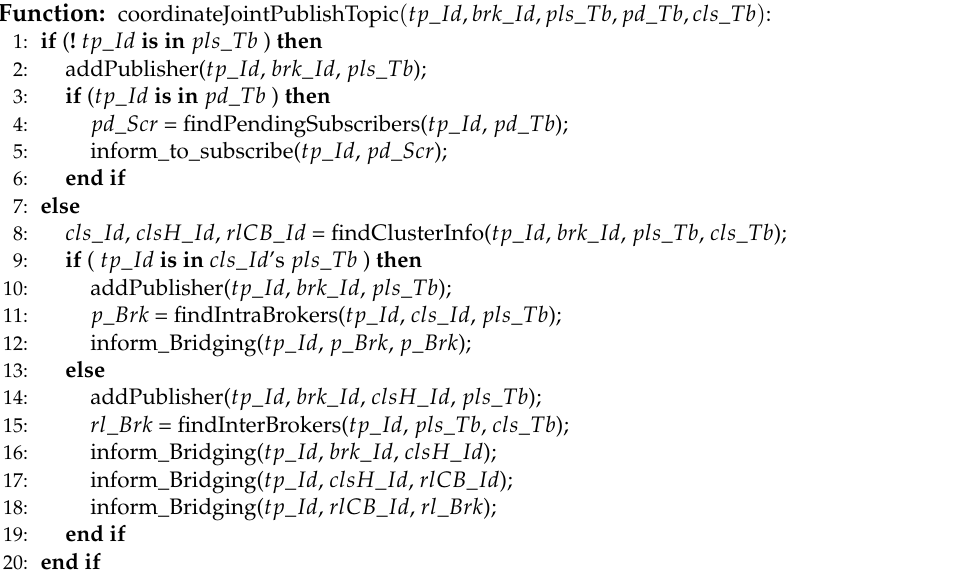
Algorithm 1 Bridging joint Publish event notifications among broker